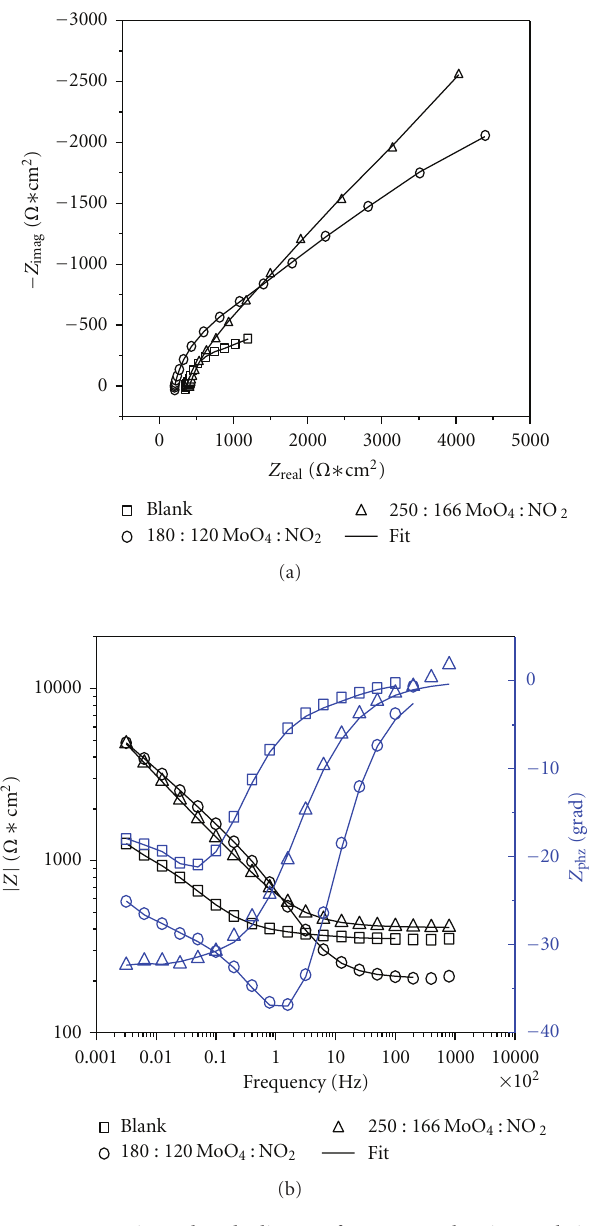
Figure 8: Nyquist and Bode diagram for Cu-CS galvanic couple in RO water with molybdate sodium and nitrite sodium.